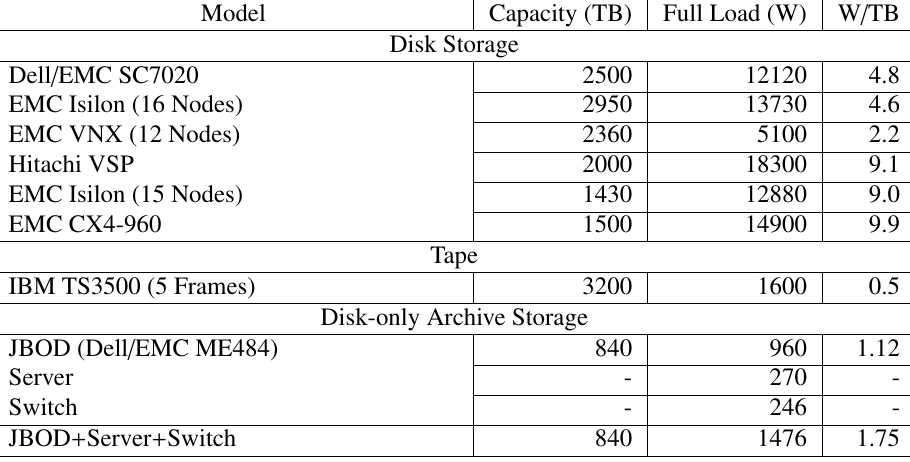
Table 4: Power consumption of disk storage and tape in production at KISTI and comparison to high density JBOD archive